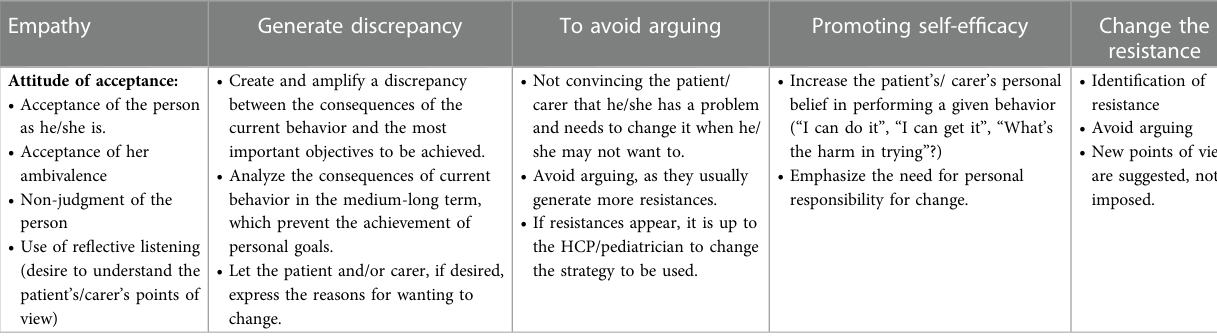
TABLE 11 Motivation style and recommendations .